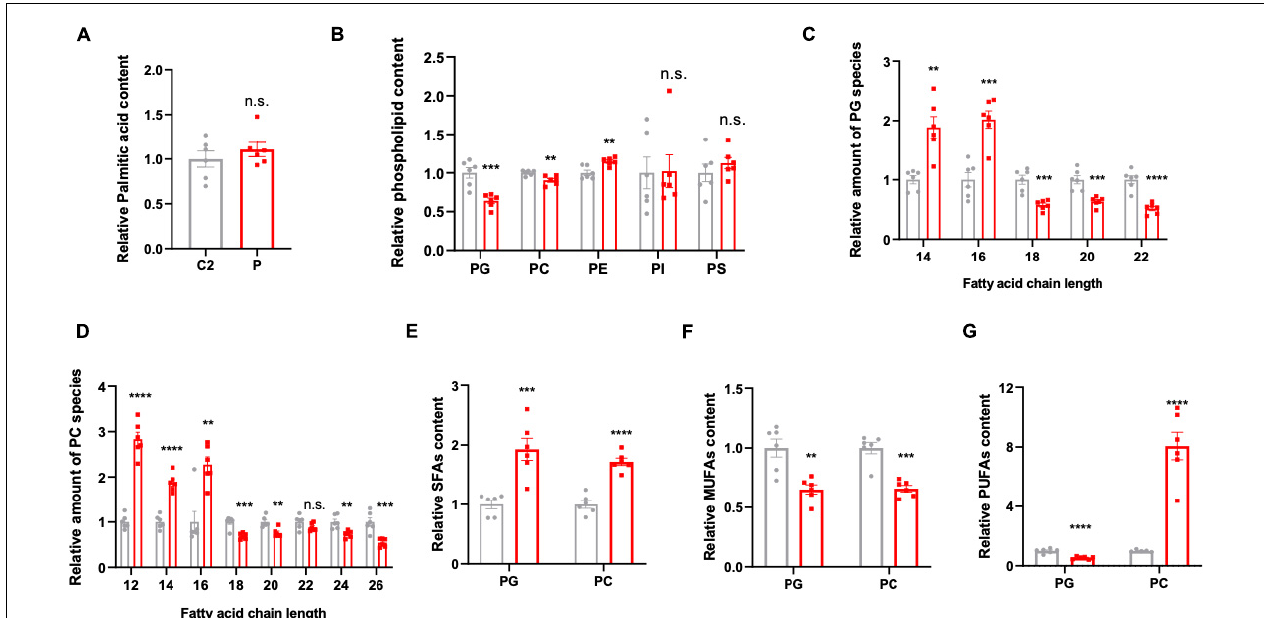
FIGURE 2 | Lipidomics analysis in the patient- and control-derived lymphocytes. (A) Relative palmitic acid content in the lymphocytes. (B) The quantification of membrane lipid components including phosphatidylglycerol (PG), phosphatidylcholine (PC), phosphatidylethanolamine (PE), phosphatidylinositol (PI), and phosphatidylserine (PS). Relative amount of substance in (C) PG and (D) PC, analyzed based on fatty acid chain length. (E) The saturated fatty acids (SFAs), (F) monounsaturated fatty acids (MUFAs), and (G) polyunsaturated fatty acids (PUFAs) were analyzed in PG and PC, respectively. All data were from six independent replicates and analyzed by mean ± SEM. Independent t -test in panels (A–G) . ** p < 0.01, *** p < 0.001, **** p < 0.0001.